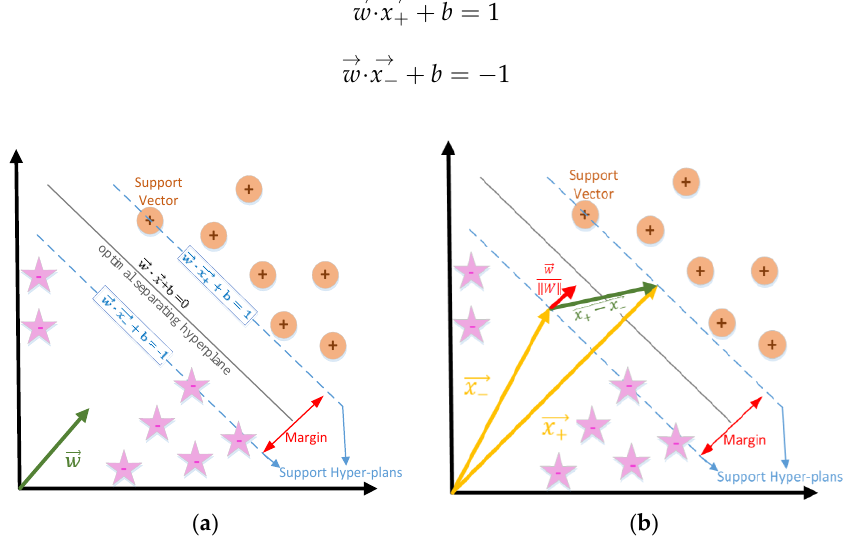
Figure 18. ( a ) Margin between two support hyperplanes; ( b ) margin is the projection of the different vector on the normal unit.